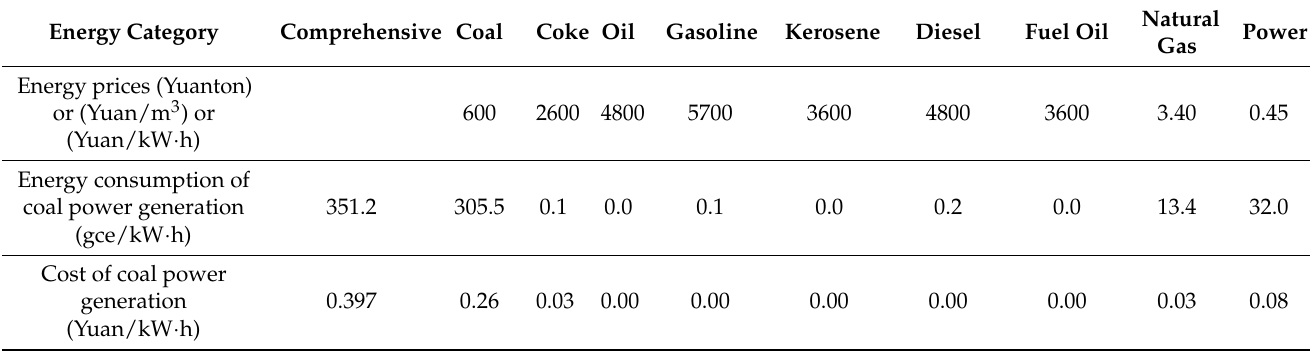
Table 8. Different energy consumption costs per unit of power generation in coal power plants.